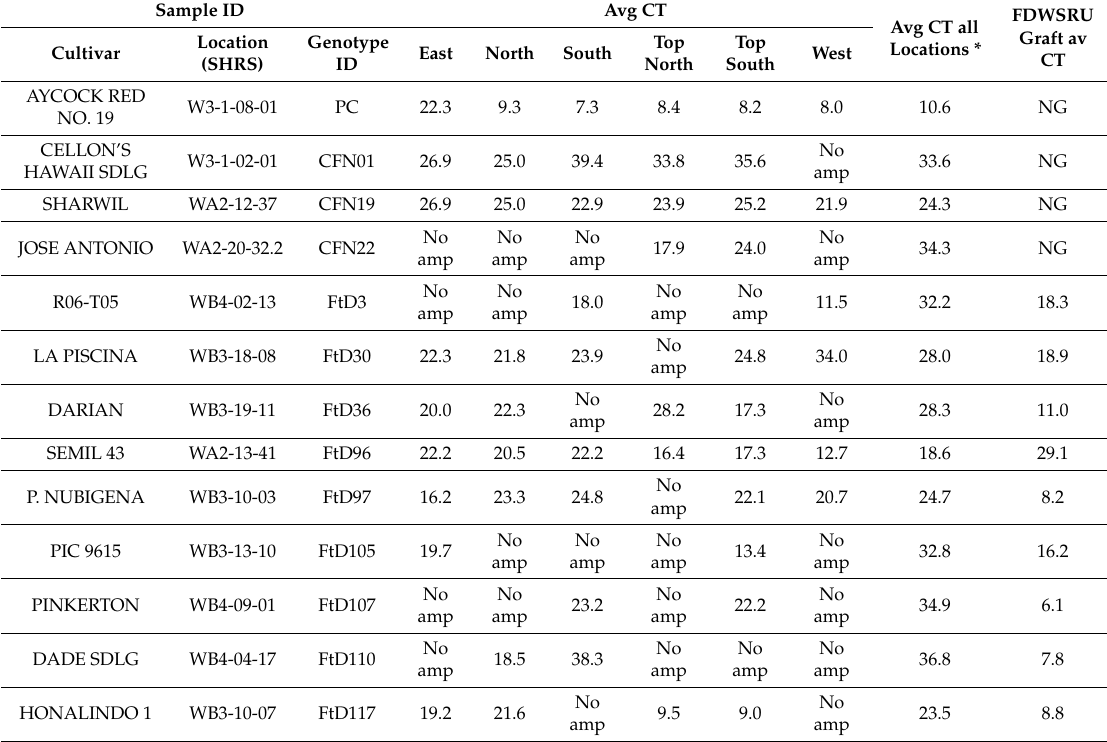
Table 4. ASBVd signal variation on di ff erent locations of the tree. Samples prepared by manual cutting. Higher viroid abundance is shown by lower average CT values. “No amp” indicates no amplification. Values for ASBVd screening of trees grafted from the individual at FDWSRU are included, (NG = tree not